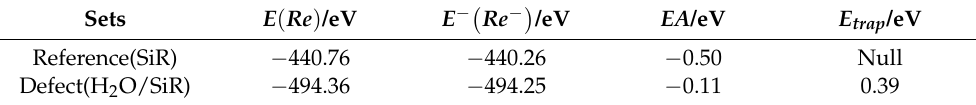
Table 2. Electron affinity and trap depth of H 2